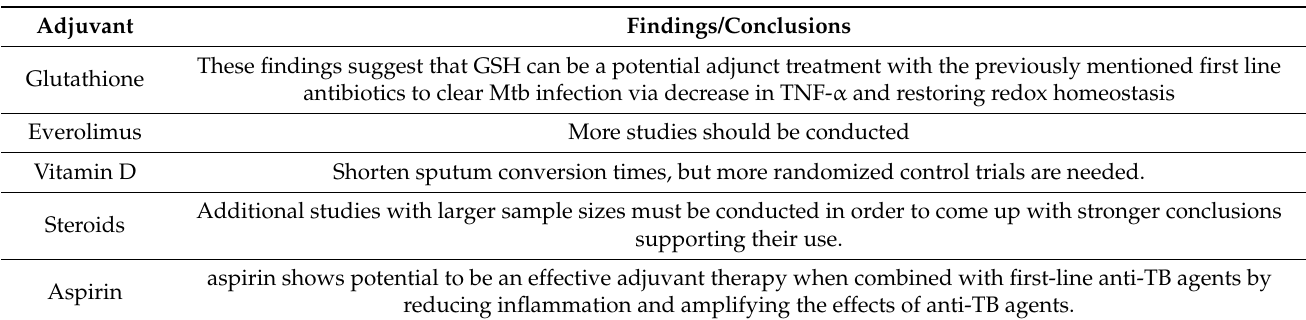
Table 3. Summary of adjuvant findings and